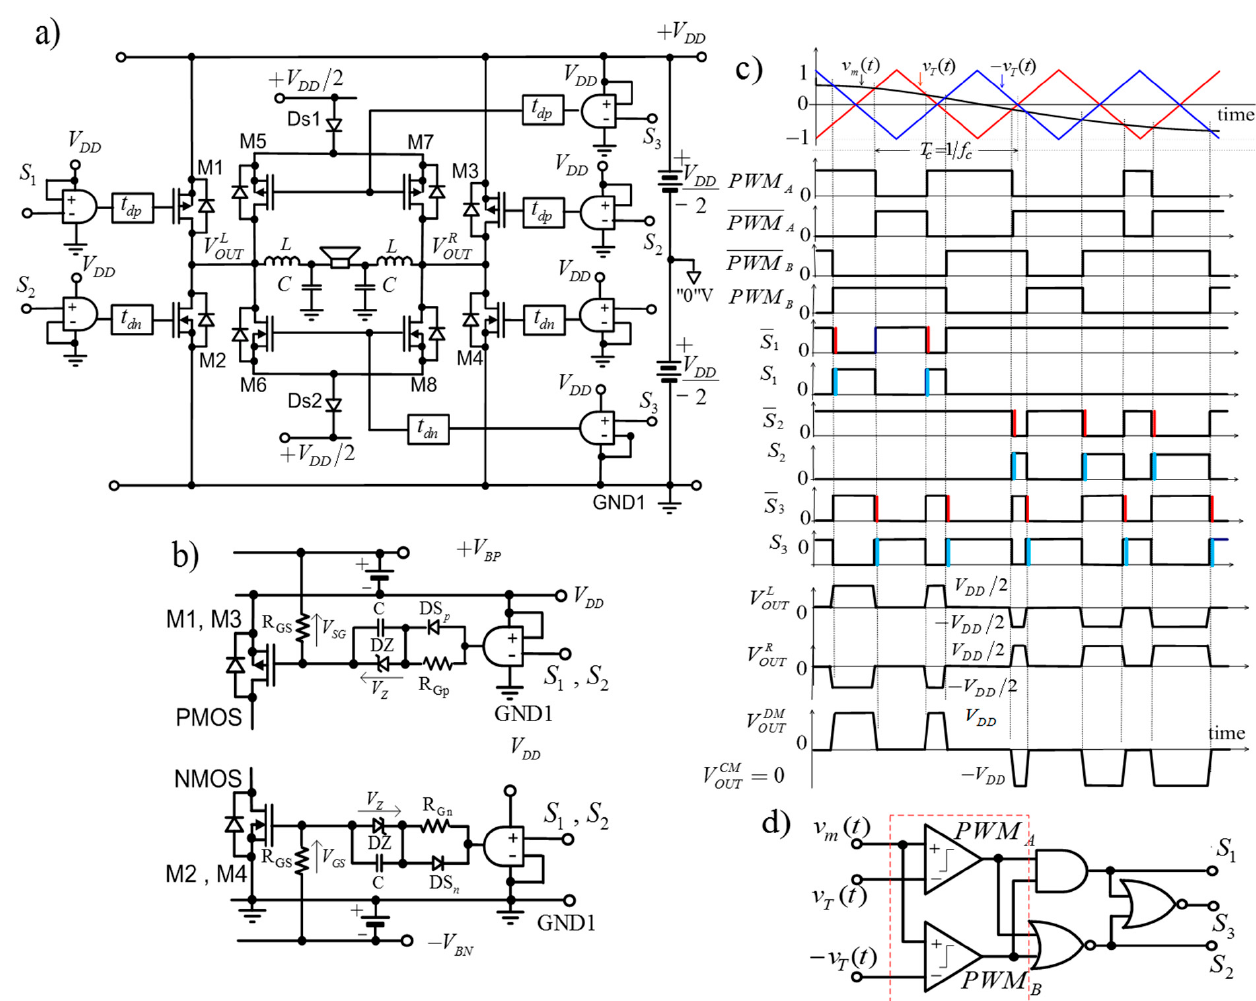
Figure 5. Class-BD audio amplifier with balanced CM output, using PSC PWM modulation scheme. ( a ) A new topology of the output stage. ( b ) Implementation of the turn-on delay times of the NMOS and PMOS. ( c ) Time domain waveforms at the amplifier outputs and PWM control signals with delayed NMOS and PMOS turn-on times (directly at the gates of these transistors). ( d ) Block diagram of the extended PSC PWM modulator.